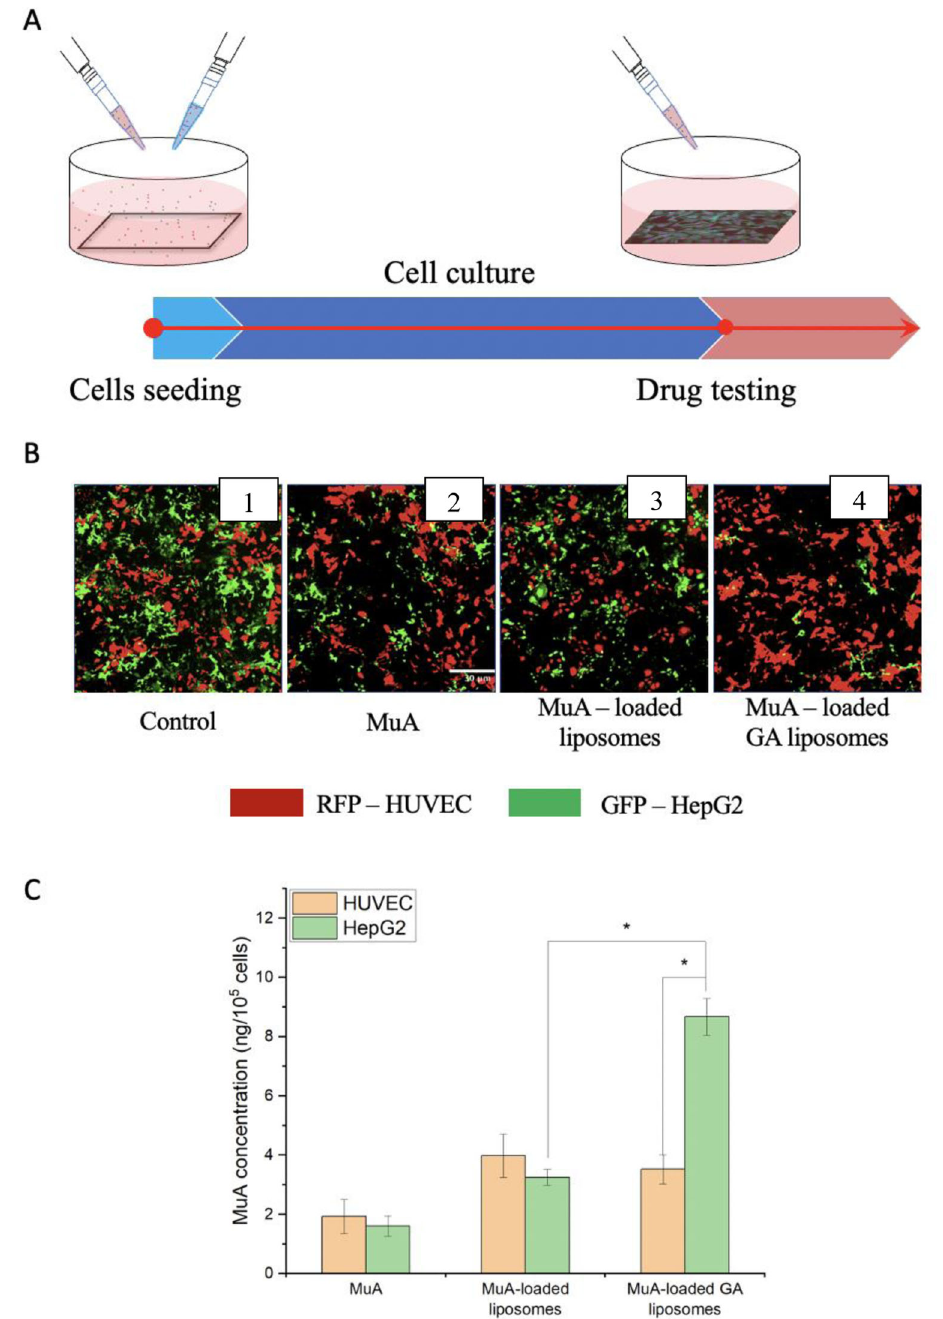
Fig. 5 In vitro cellular uptake of various liposomes against HUVEC and HepG2 cells cocultured. A Schematic diagram of cocultures platform and drug testing; ( B ) Cell morphology of cocultured HUVEC and HepG2 cells before and after treatment with MuA- loaded GA liposomes. C Cellular uptake of HepG2 cells against various liposomes. Data are presented as the mean ± SD ( n = 3, * p <